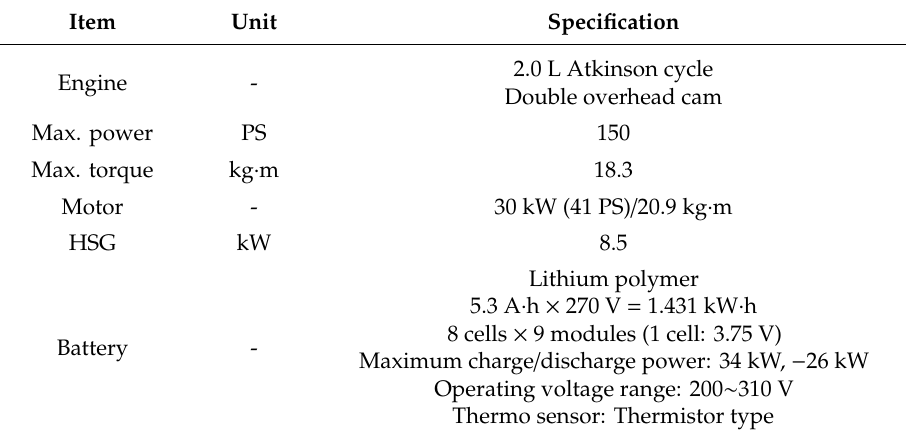
Figure 2. Parallel type hybrid electric vehicle and chassis dynamometer. Table 1. Specifications of the HEV used in the current study.